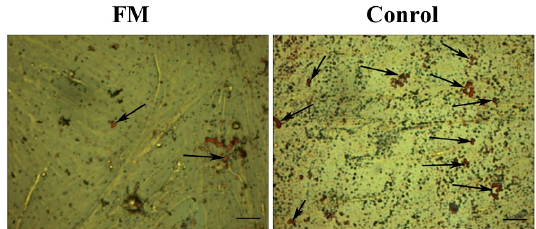
Figure 4. FGF21 suppressed the accumulation of triglycerides. Oil red staining results showed less lipid droplets in FM cells ( A ) than that in the control ( B ) (bar = 100 μ m). The arrows indicated the lipid.